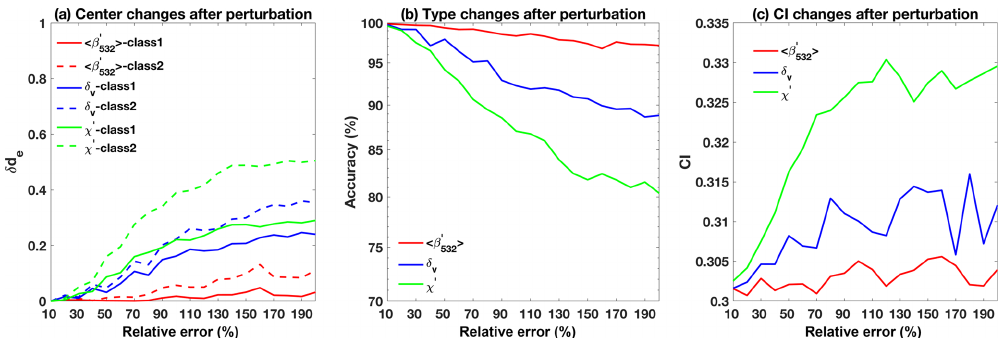
Figure 13. Classification changes as a function of errors in the input parameters. Panel (a) shows shifts in cluster centers for each class; panel (b) shows the relative accuracy of the FKM classifications; and panel (c) shows changes in the cluster confusion indexes. Panels (b) and (c) show perturbations in the classifications due to uncertainties in attenuated backscatter intensity ( (cid:104) β (cid:48) in blue), and color ratio ( χ (cid:48) , in green).